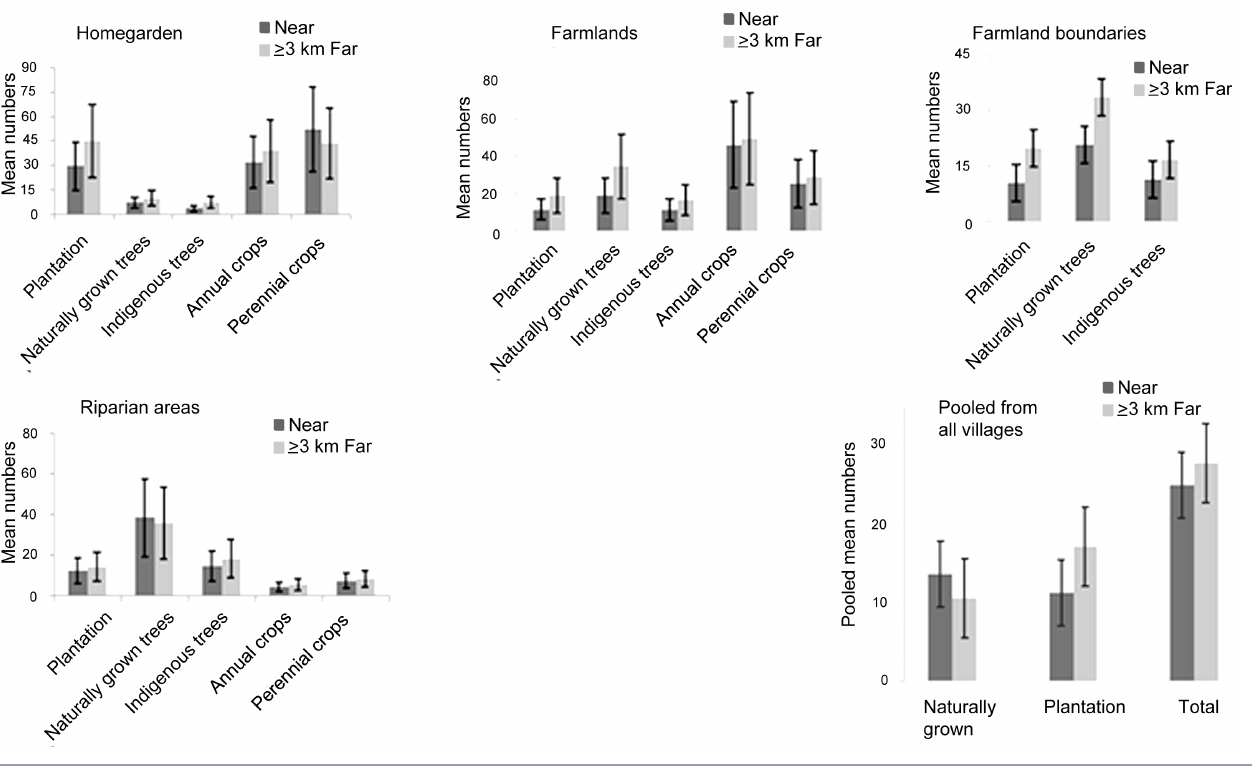
Fig. 2. Mean numbers of tree species and food crops recorded in homegardens, inside farmlands, along farmland boundaries, and in riparian areas. The statistical interpretations of the patterns are found in the text. Error bars are standard error. The sample size is found in Table